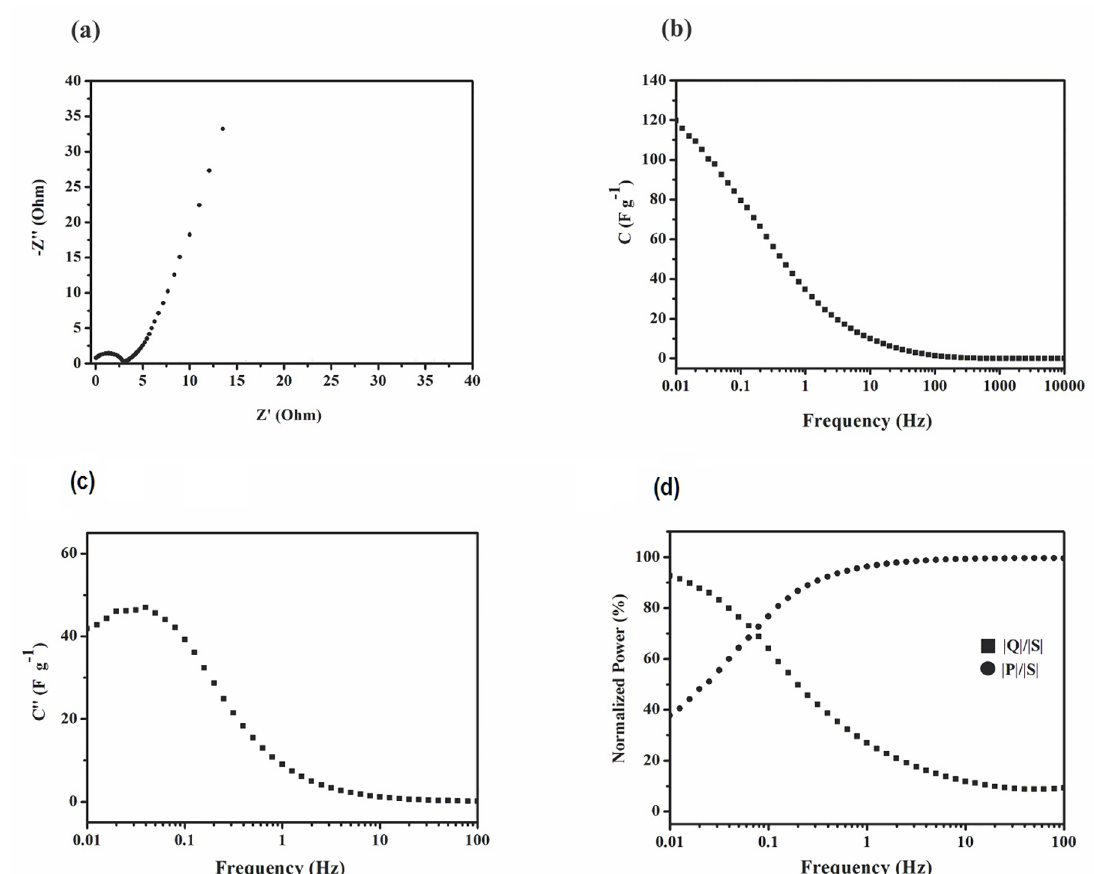
O nanoparticles and (b) Behavior of the specific capacitance as a function 3 4